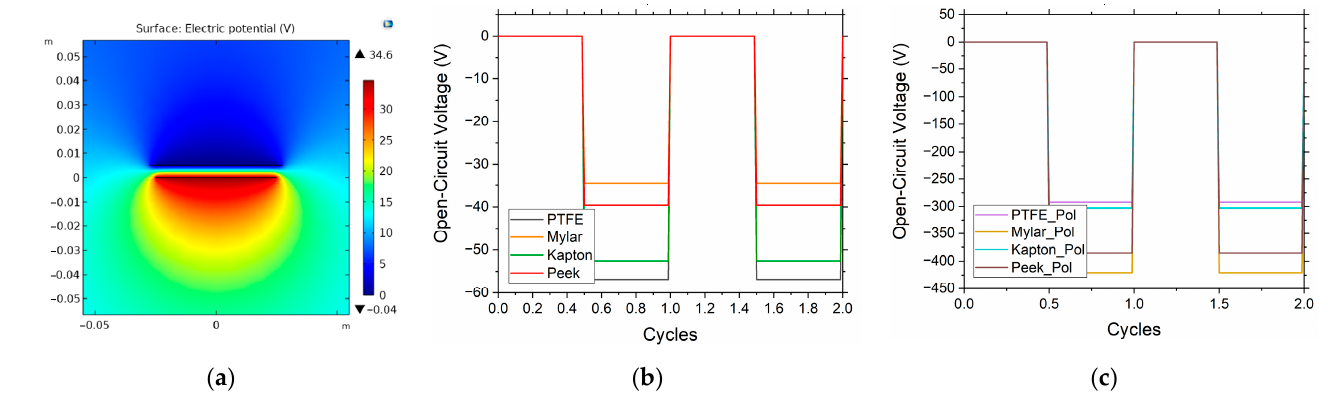
Figure 7. ( a ) Electric potential (in volts) generated by the Mylar sample with an electrode separation of 5 mm. ( b , c ) Open-circuit voltage for different triboelectric materials without and with corona charging,